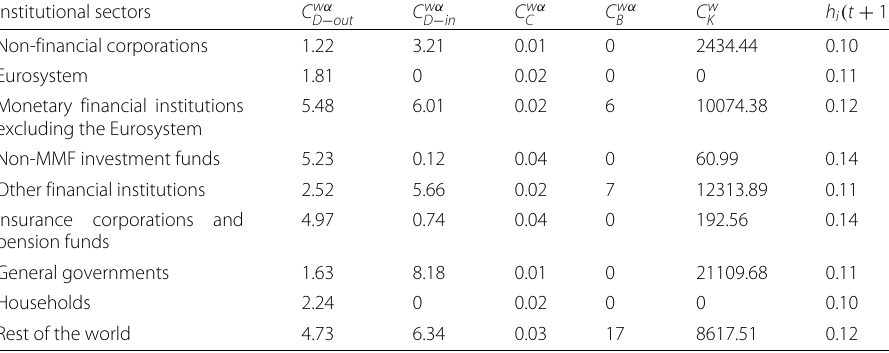
Table 2 Network statistics - debt security layer